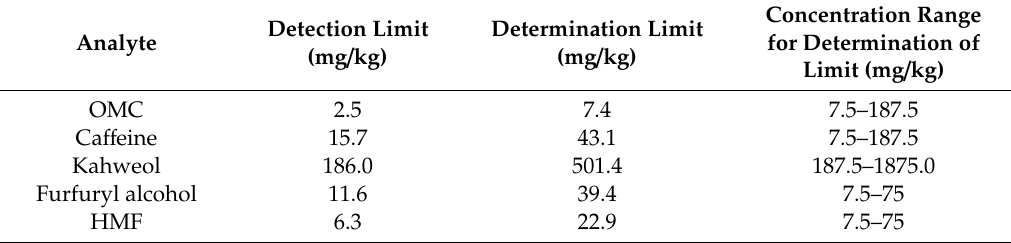
Table 5. Limits of detection and quantification of analytes determined.